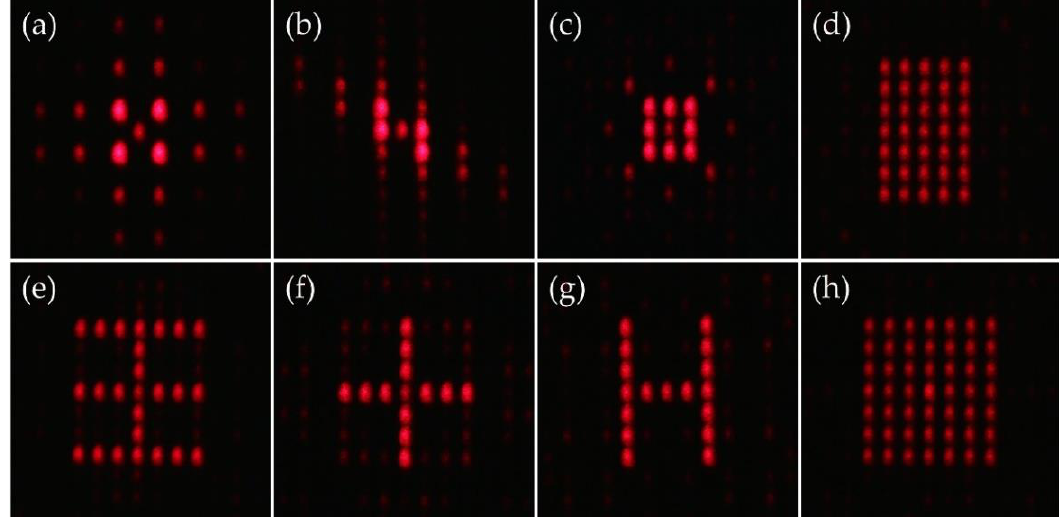
Figure 8. Diffraction pattern of the 1 # DOE with etching depth of 550 nm. Theoretical depths of the eight patterns are ( a ) 537 nm, ( b ) 537 nm, ( c ) 580 nm, ( d ) 644 nm, ( e ) 633 nm, ( f ) 608 nm, ( g ) 619 nm, and ( h ) 655 nm.